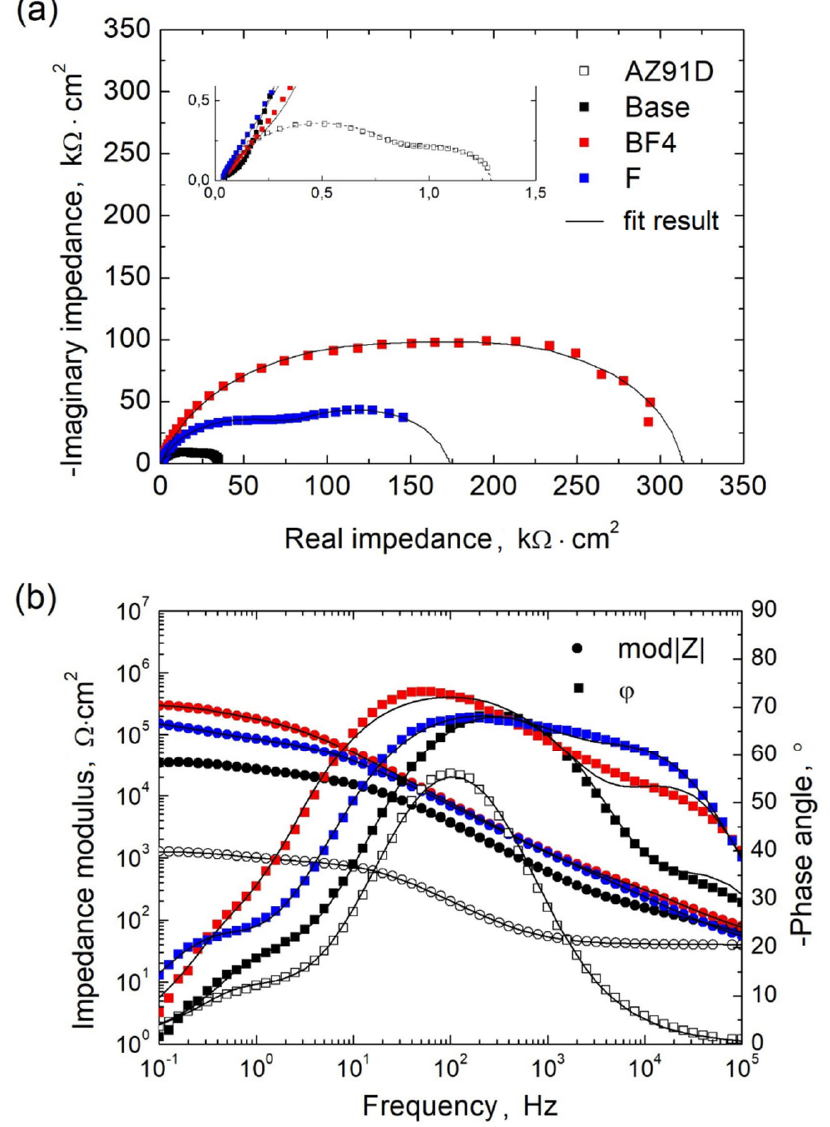
Figure 9. Results of EIS measurements for the uncoated AZ91D Mg alloy and the PEO treated samples in different electrolytes: ( a ) Nyquist; ( b ) Bode plots.